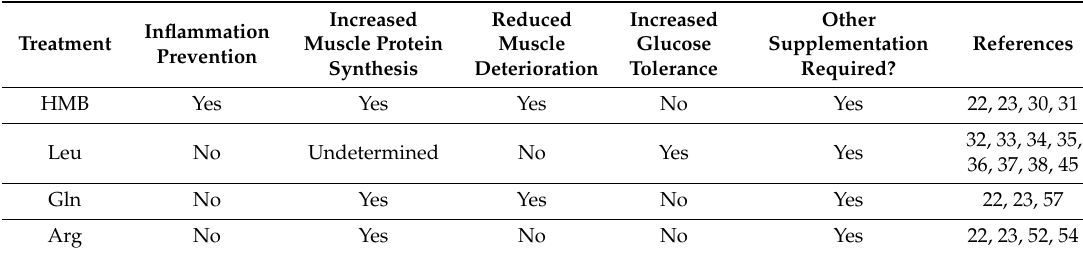
Table 1. Summary of various amino acid supplementation regimes and their e ff ects on health outcomes associated with